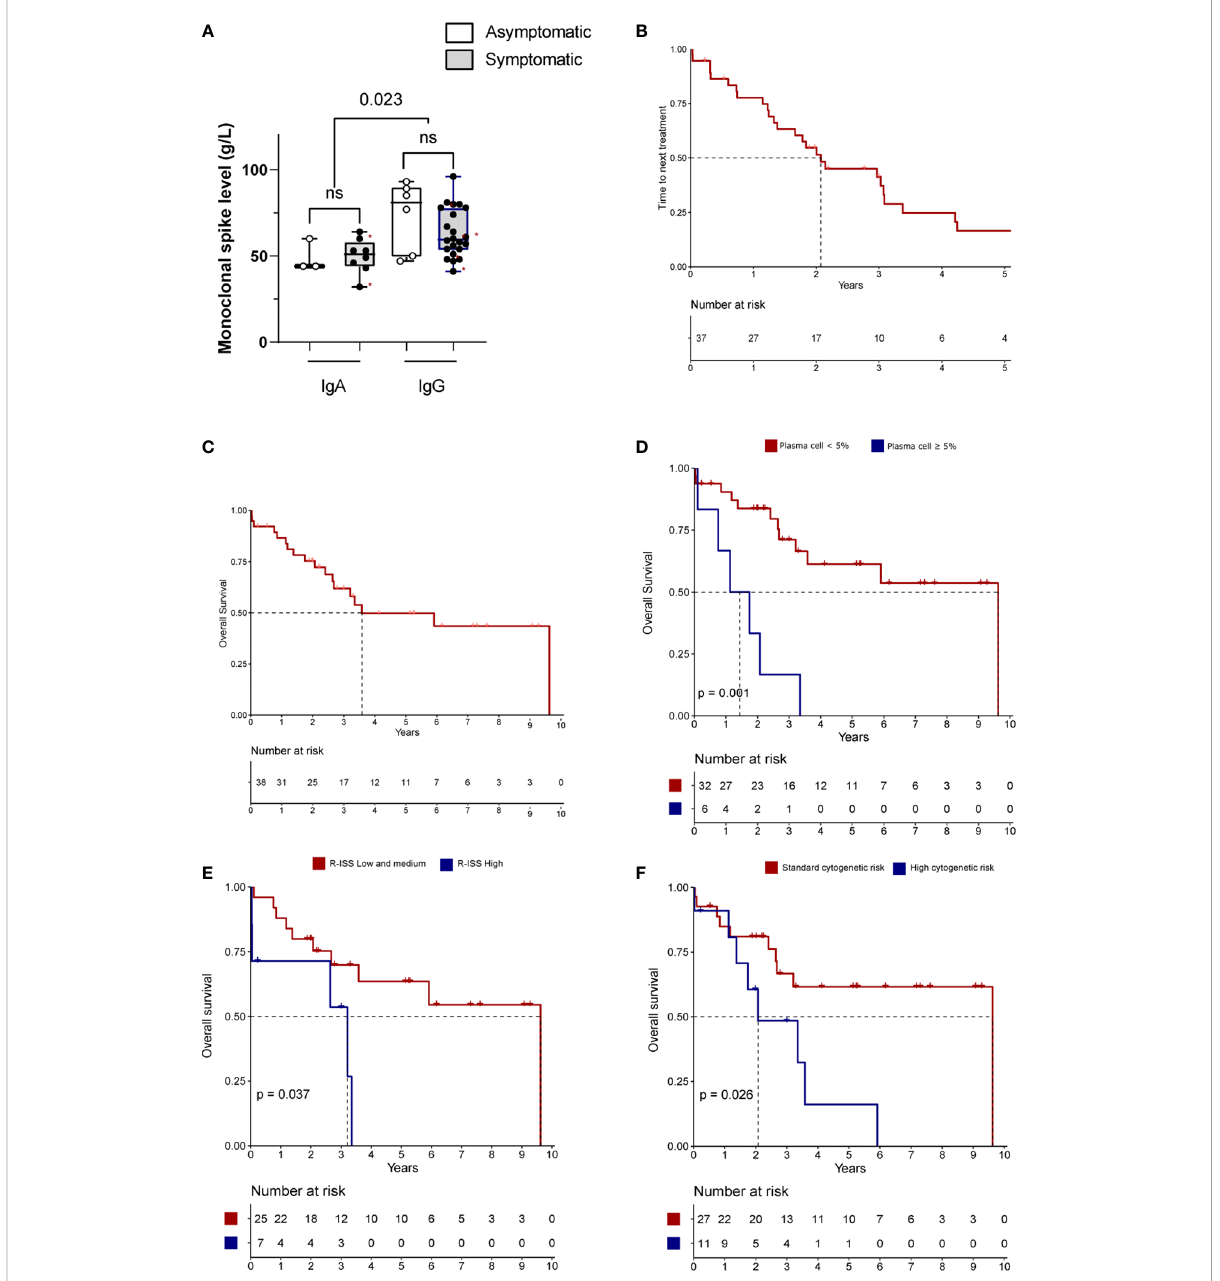
FIGURE 2 Description and outcomes of HVS NDMM (A) Monoclonal protein level between Ig type and HVS symptoms for NDMM. Red stars denote severe cases with neurological symptoms. (B – F) Survival of HVS NDMM patients. Time to next treatment (B) and overall survival (C) of NDMM with HVS. (D – F) Overall survival based on presence of plasma cells in blood by cytology analysis (D) , score R-ISS (low=R-ISS1 and R-ISS2; high=R-ISS3) (E) and cytogenetic risk (high risk= presence of t(4;14) or del(17p) by FISH; standard risk=others) (F) . Number of patients could vary related to missing data. NS, not signi fi